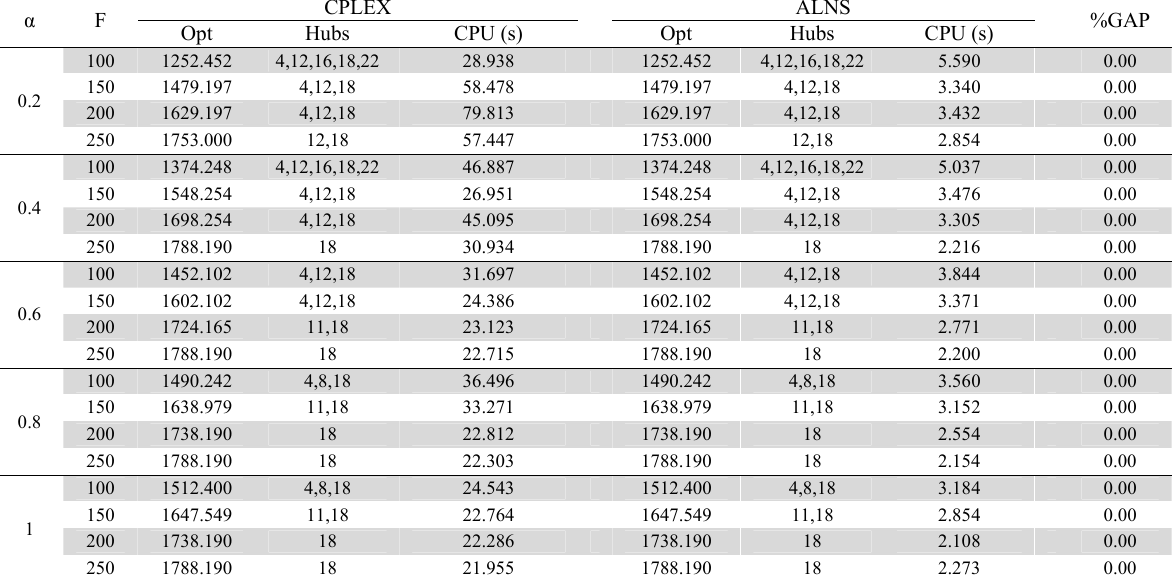
Results for the CAB data set with θ = 3000